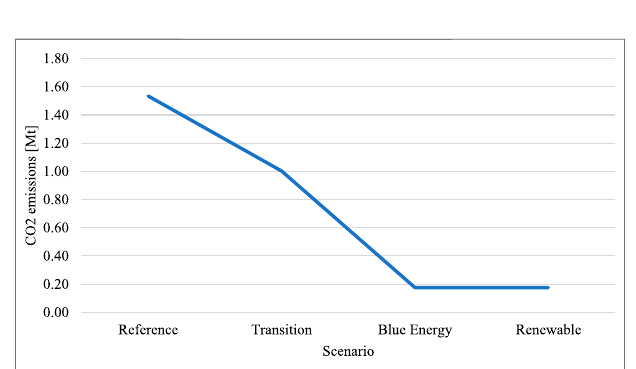
FIGURE 12 | CO 2 emissions for energy, residential, and industrial sectors.